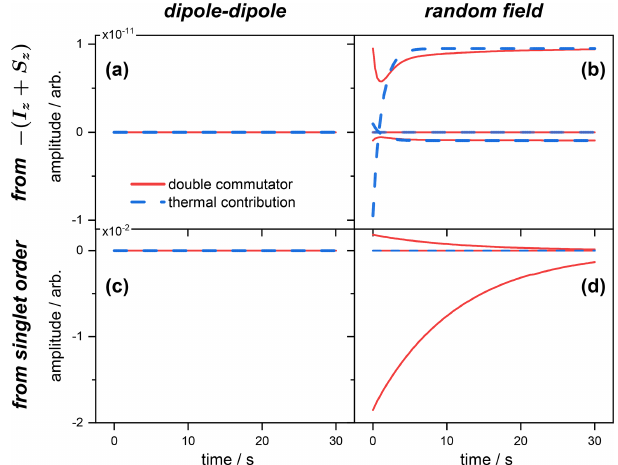
Figure 2. Same as Fig. 1 for the expected value of the singlet oper- ator O = 1 1 − I · S 4